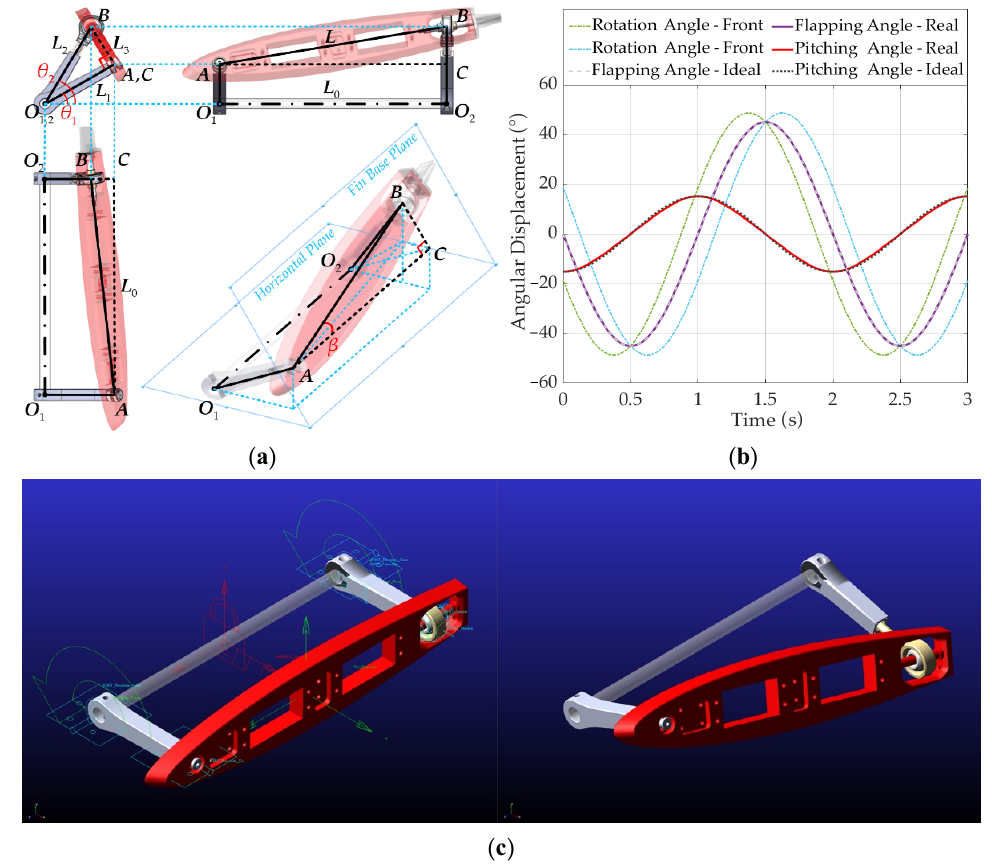
Figure 3. Kinematic analysis of the mechanism. ( a ) Geometric relationship of the fin components; ( b ) Comparison between the real motion trajectory and the ideal pattern; ( c ) Motion simulation environment of